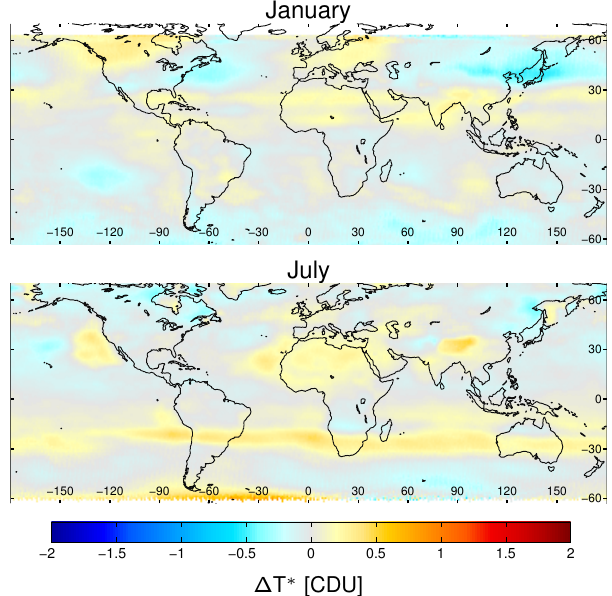
Figure 9. Monthly mean difference of tropospheric residues T ∗ from DOMINO and STREAM for OMI measurements in Jan- uary (top) and July (bottom)